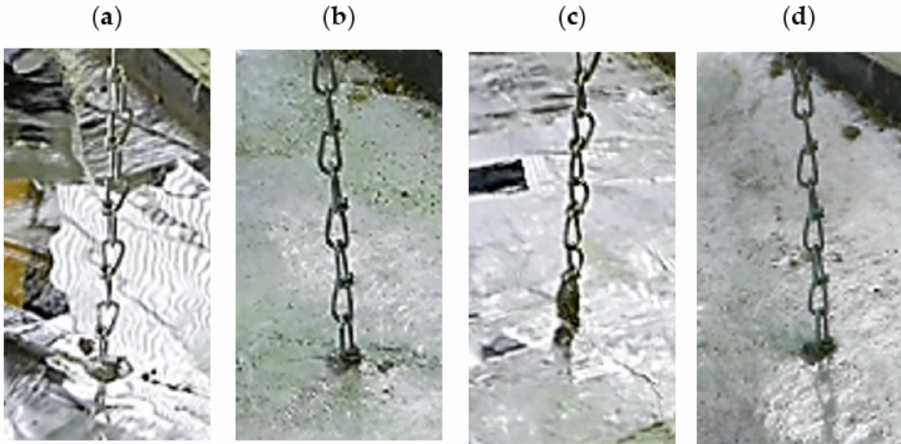
Figure 9. Comparison of the task-related efficiency of the skimming methods: ( a ) Two-step sinusoidal movement—mechanical system; ( b ) Two-step sinusoidal movement—gas-based system; ( c ) High- intensity pulse wave method—mechanical system; ( d ) Linear movement—gas-based